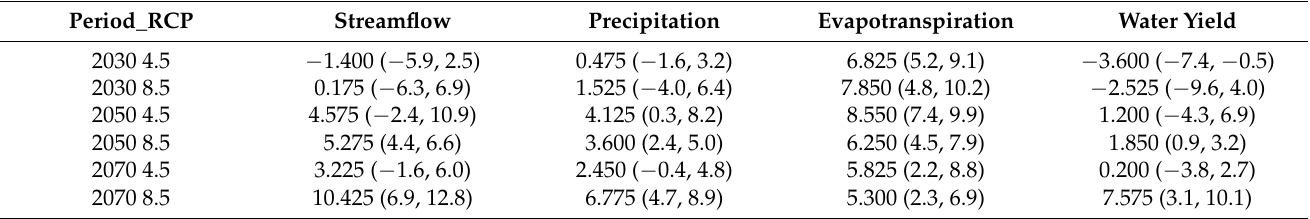
Table 6. Projected changes of water balance components from baseline trends (1980–1999) for three future periods (2030s, 2050s, 2070s) under two RCPs (4.5, 8.5) in Deckers Creek Watershed, Morgantown, West Virginia, USA. Ensemble mean for four GCMs with the ensemble minimum and maximum on the